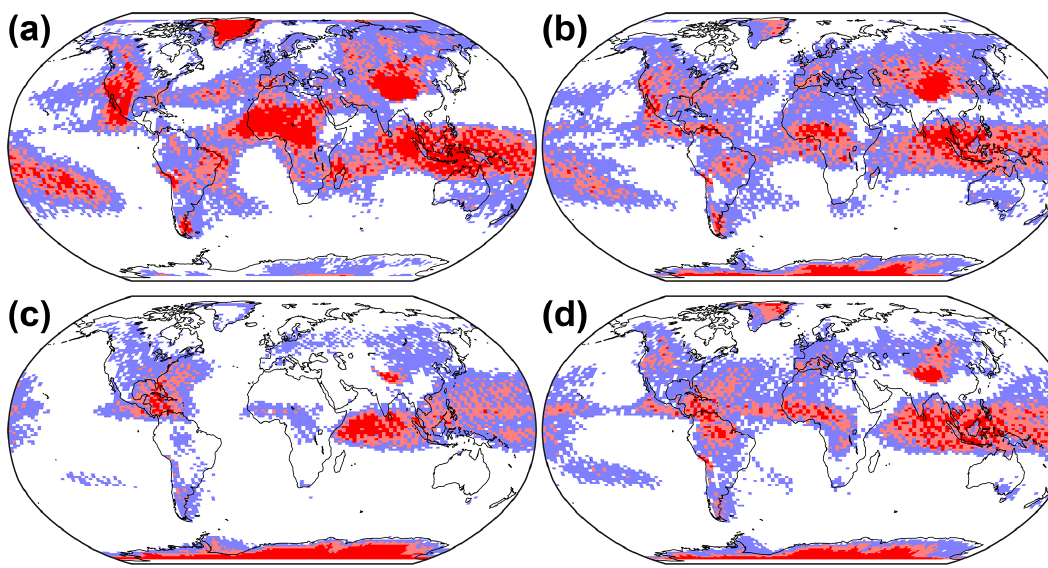
Figure A5. Same as Fig. 9a but for the 3-month periods (a) DJF, (b) MAM, (c) JJA, and (d) SON.